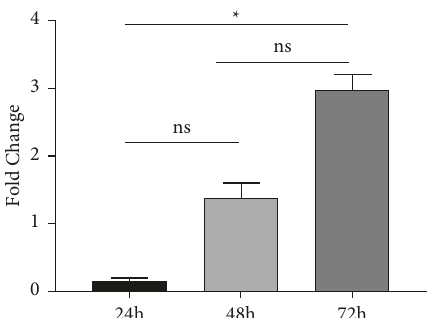
Figure 2: Fold change of IL-6 mRNA transcription in HEK-293T cells transfected with mock and B19NS1 vectors overtime in four experiments.